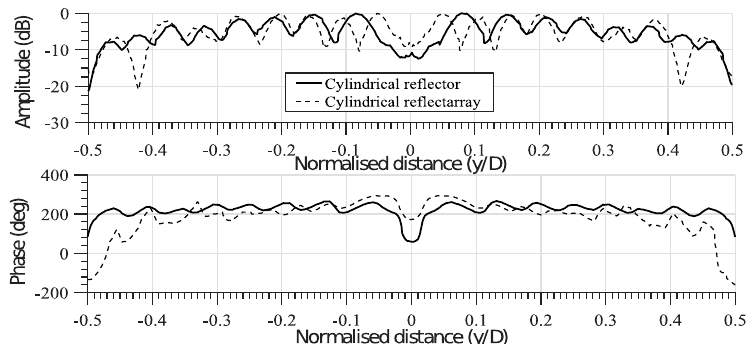
19.69 Figure 3. Comparison of the simulated gain performance for a 𝐿 (cid:4593) (cid:3400) 𝐷 portion of the classical parabolic reflector (dotted line) and of the segmented reflectarray (continuous line). 𝐿 (cid:4593) = 5 mm , 𝐷 = 30 cm for the cylindrical parabolic reflector and 𝐷 = 44 mm for the cylindrical reflectarray. To better understand how the segmented reflectarray works, the electric field amplitude and